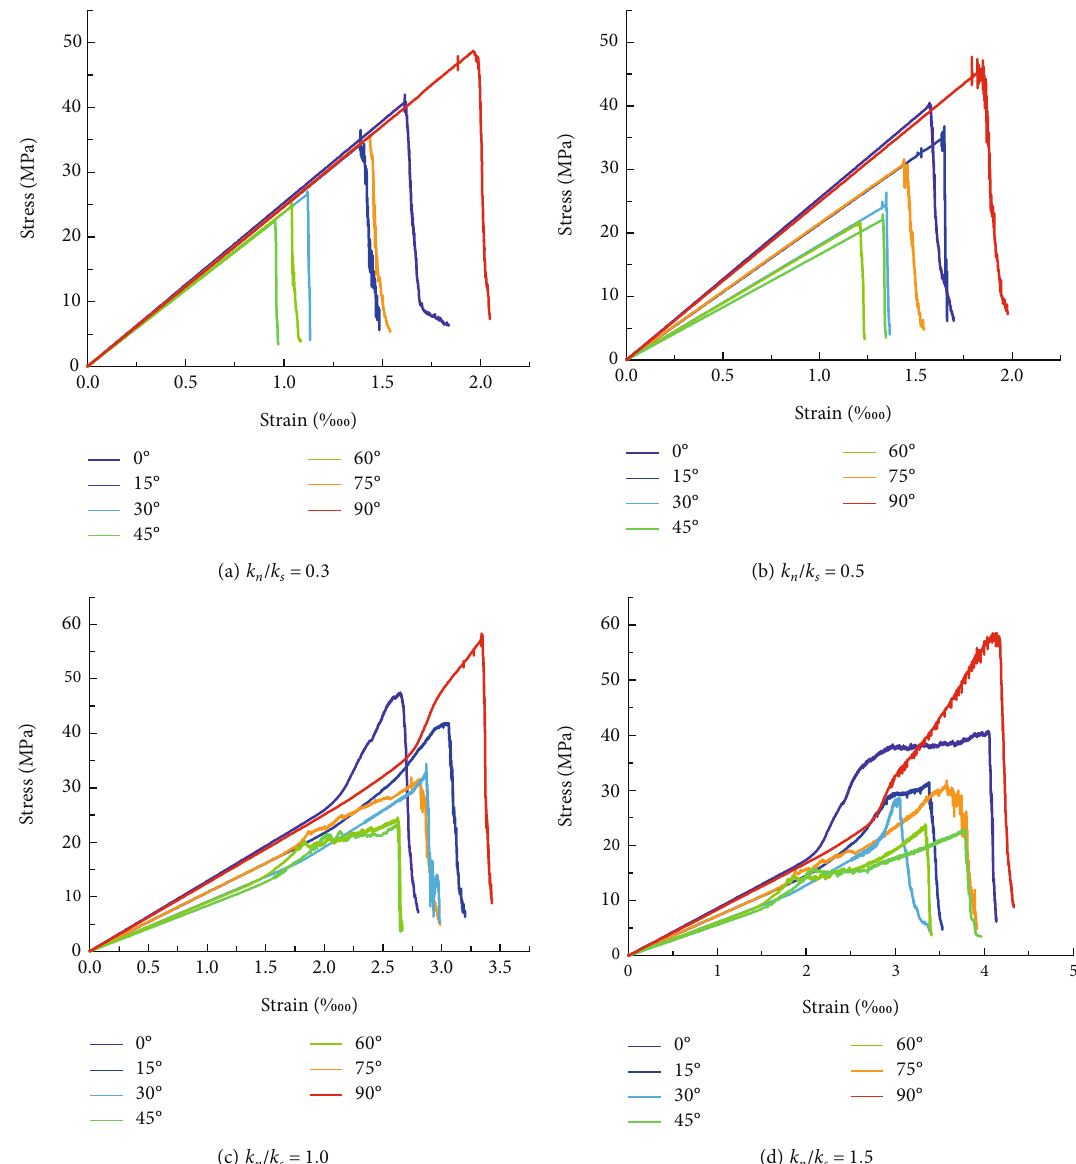
Figure 16: Stress-strain curves of rock mass with di ff erent sti ff ness